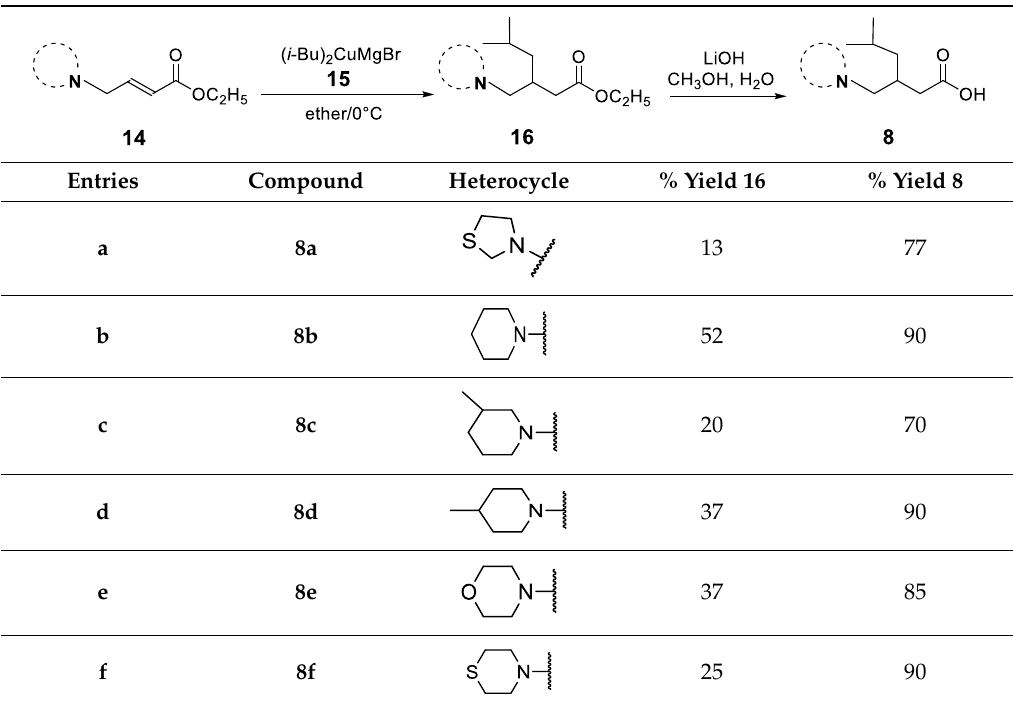
Table 3. Synthesis of the β -substituted analogues 8 .